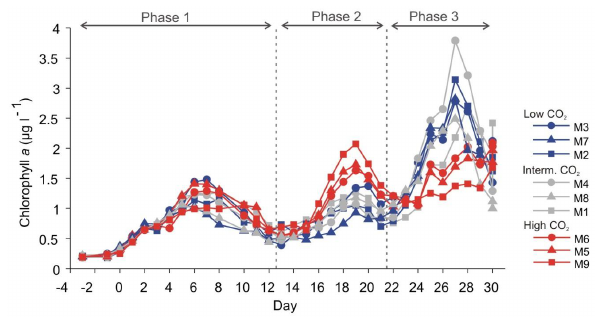
Figure 1 2 Fig. 1. Chlorophyll a concentration (µ g l − 1 ) in the different meso- cosms (M1-M9) and in the fjord during the experiment. Data from mesocosms with low CO 2 concentration (170–270µatm), interme- diate CO 2 concentration (370–717µatm) and high CO 2 concen- tration (544–1825µatm) are marked in blue, grey, and red, re- spectively. The different phases of the experiment are indicated (Phase 1=day –4 to 12, Phase 2=day 13 to 21, Phase 3=day 22 to